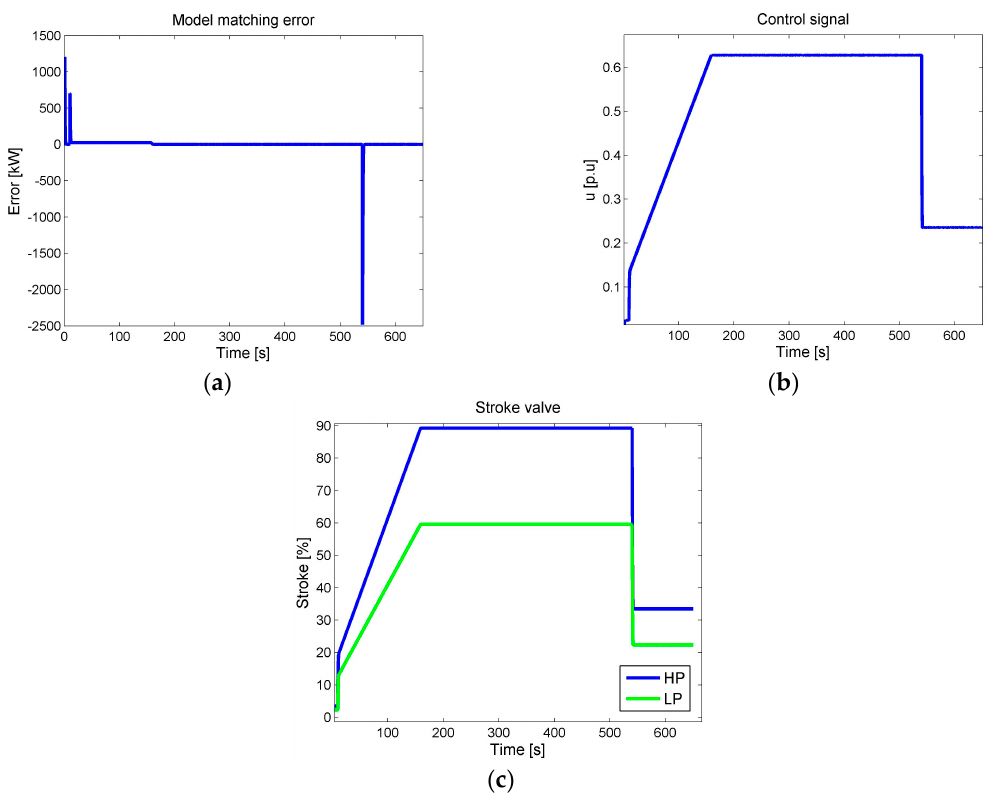
Figure 16. Nominal performance objectives: ( a ) Ideal model matching error; ( b ) control action; ( c ) stroke valves. Table 1. (cid:1834) (cid:2998) controller set-point performance indexes.